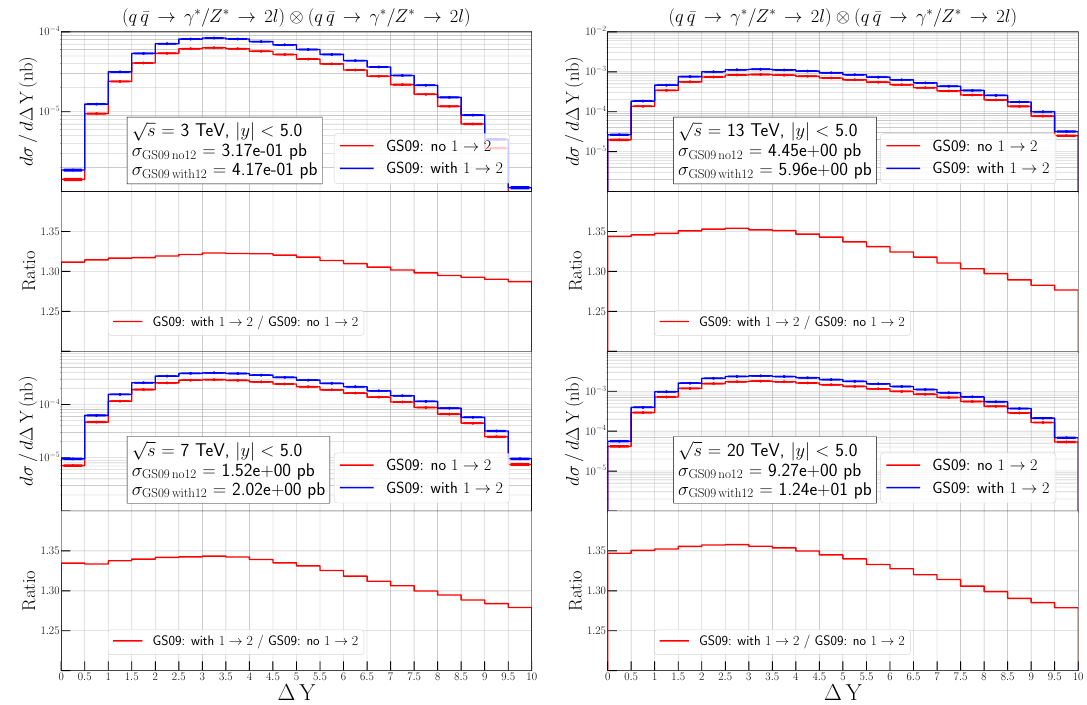
Figure 13 . Comparison between ∆Y = max | y i − y j | DPS distributions generated with the GS09 dPDFs produced by solving dDGLAP evolution equation with and without 1 → 2 splitting. The √ collision energy S is equal to 3 , 7 , 13 and 20